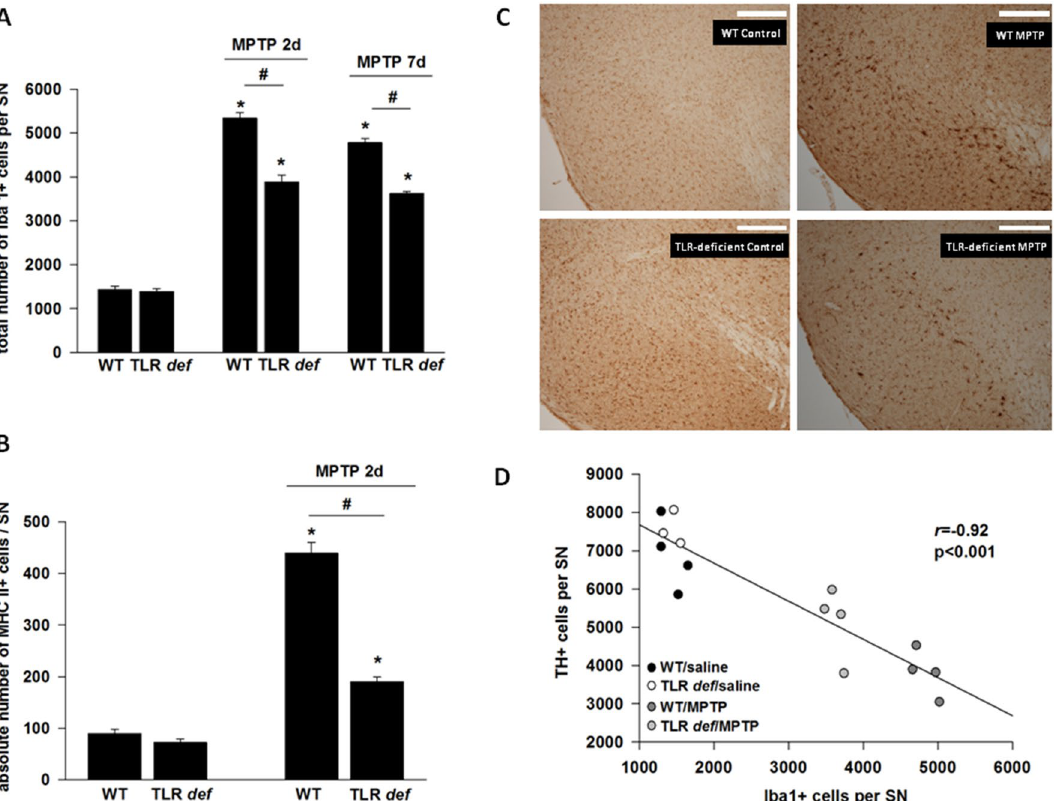
Figure 2. ( A ): Number of nigral Iba+ microglia at day 2 and day 7. WT = WT mice, TLR def = TLR4-deficient mice. Values are expressed as mean ± SEM (*p < 0.05 comparing MPTP-treated group with its saline control, # p < 0.05 comparing MPTP-treated groups of WT and TLR4-deficient mice). ( B ): MHC II+ cell number in SN after MPTP treatment at day 2. WT = WT mice, TLR def = TLR4-deficient mice. Values are expressed as mean ± SEM (*p < 0.05 comparing MPTP-treated group with its saline control, # p < 0.05 comparing MPTP-treated groups of WT and TLR4-deficient mice). ( C ): Representative photographs of the SN (Iba-1 staining) of each treatment group at day 2 are shown. TLR4 def = TLR4-deficient mice, WT = wild-type mice. Control = saline treated mice, MPTP = MPTP treated mice. Scale bars = 200 μm. ( D ): Correlation analysis of TH+- and Iba+- positive cells counts at day 7 in SNpc (r = −0.92, p <